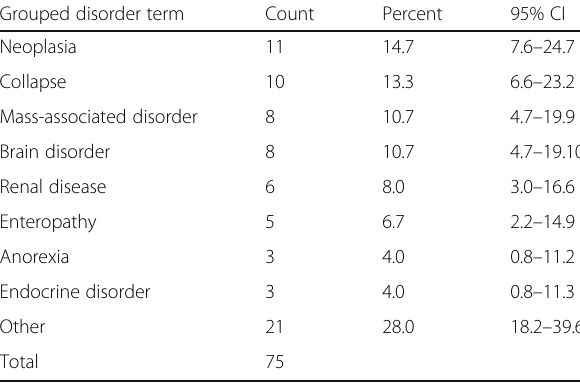
Table 2 Grouped causes of mortality in Miniature Schnauzers